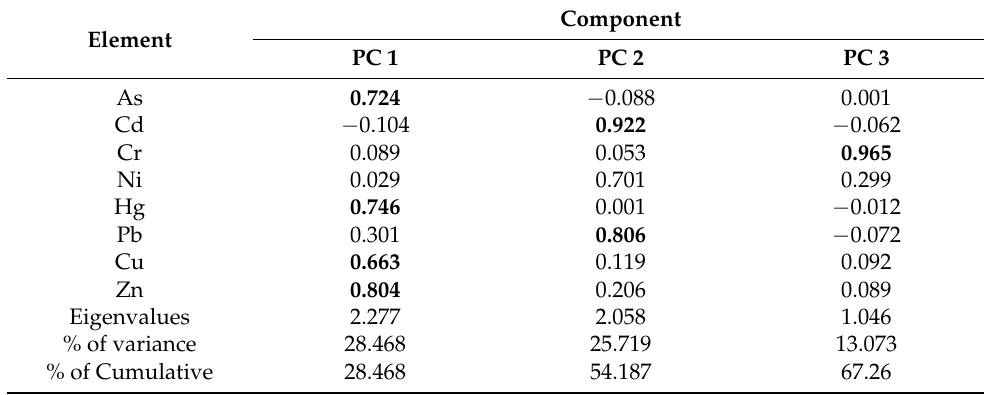
Table 6. Principle component analysis of heavy metals in industrial land soil.